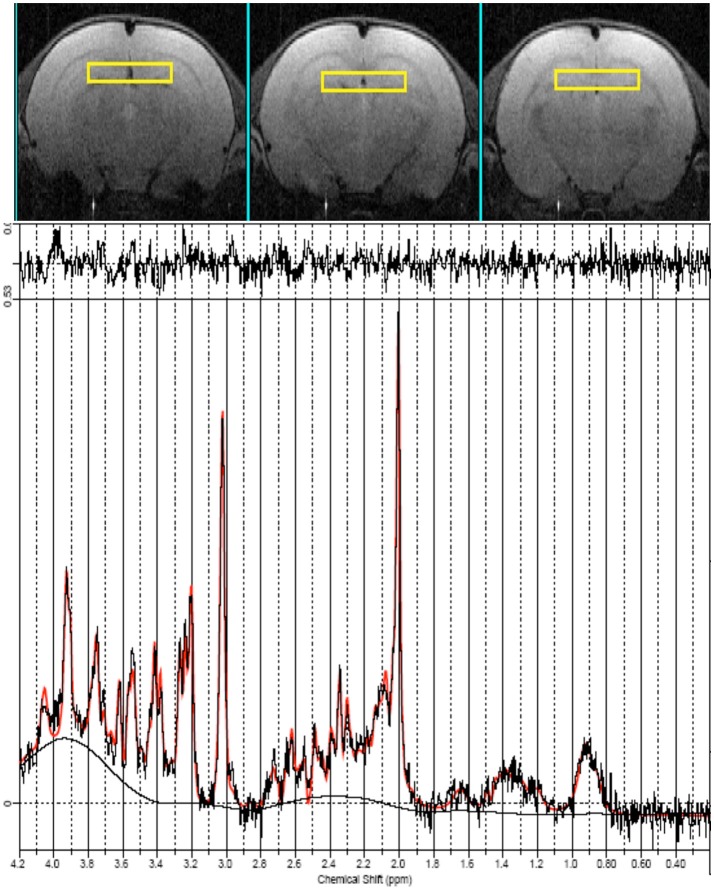
MRI panel—Example of in vivo axial T2-weighted spin-echo consecutive images (TR/TE = 2,500/50 ms, slice thickness 1 mm, NS = 2, FOV = 25 × 25 mm2, matrix 128 × 256) of a “mid” age-stage rat (PND 28–32). The Voxel is localized on the anterior part of the Hip and is indicated by the yellow rectangles. MRS panel—Representative in vivo 1H spectra (black trace), acquired from the Hip (PRESS, TR/TE = 4,000/23 ms, NS = 256). Overimposed (red trace), the result of LCModel fit.